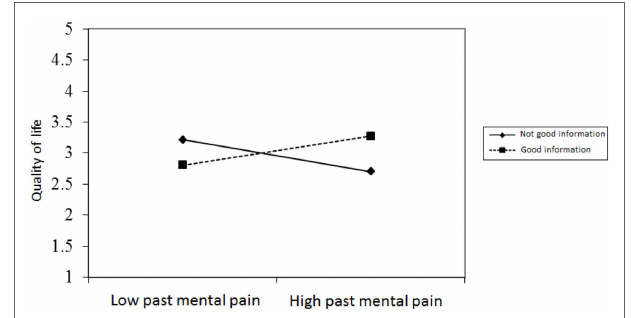
FigUre 2 | The relationship between past mental pain and quality of life in the two information groups